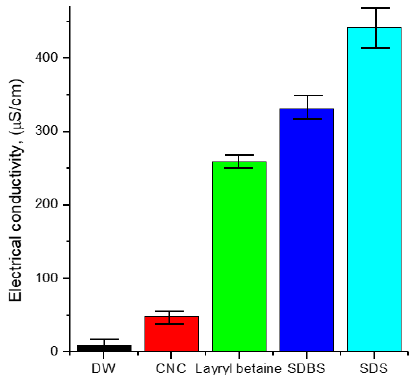
Figure 3. Electrical conductivity of each surfactant.